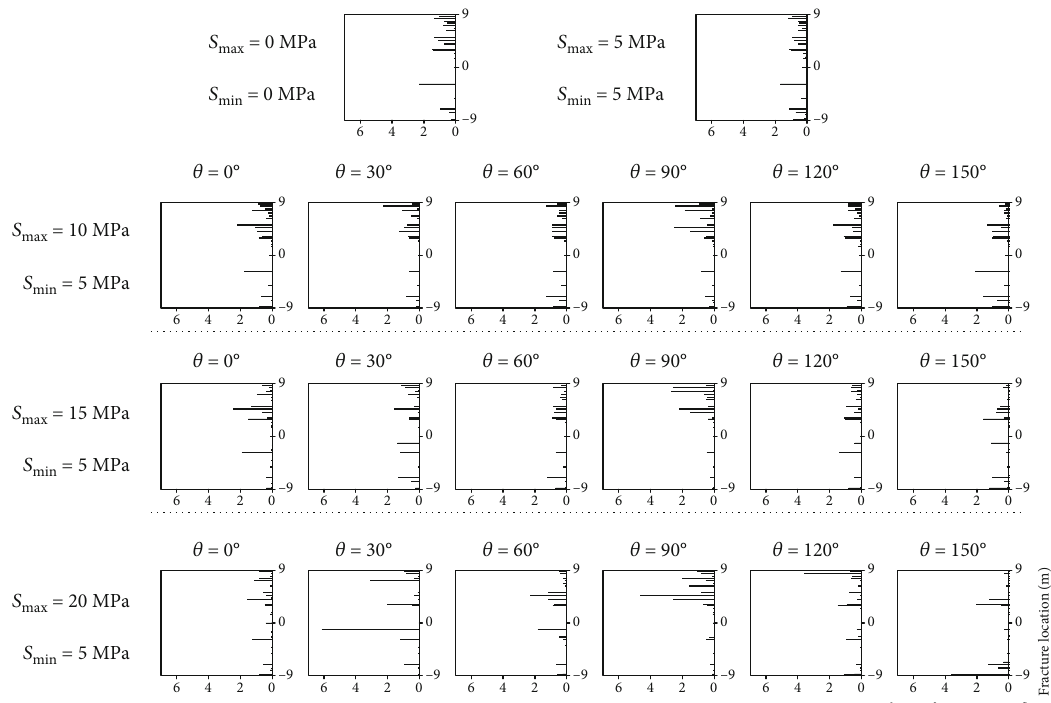
Figure 8: Flow rate distributions at the outlet of fracture networks under di ff erent stress